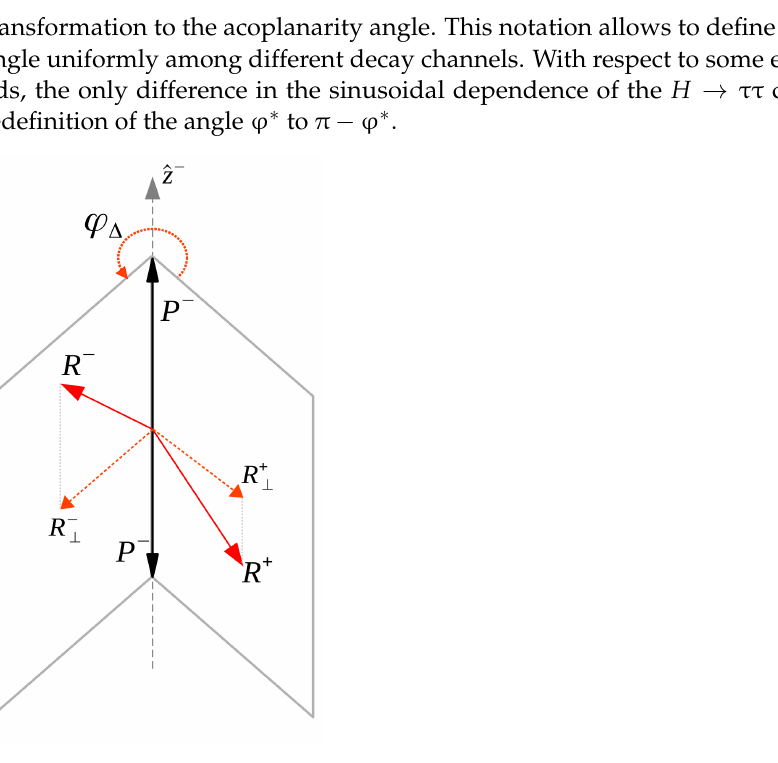
Figure 3. Schematic representation of the acoplanarity angle definition based on the notation pro- posed in this paper. The vectors R ± ⊥ are vectors lying on the respective decay planes and orthogonal to the axis formed by the vectors P ± . The acoplanarity angle ϕ ∆ is defined, starting from the τ + decay plane, as a counter-clockwise rotation with respect to the ˆ z −